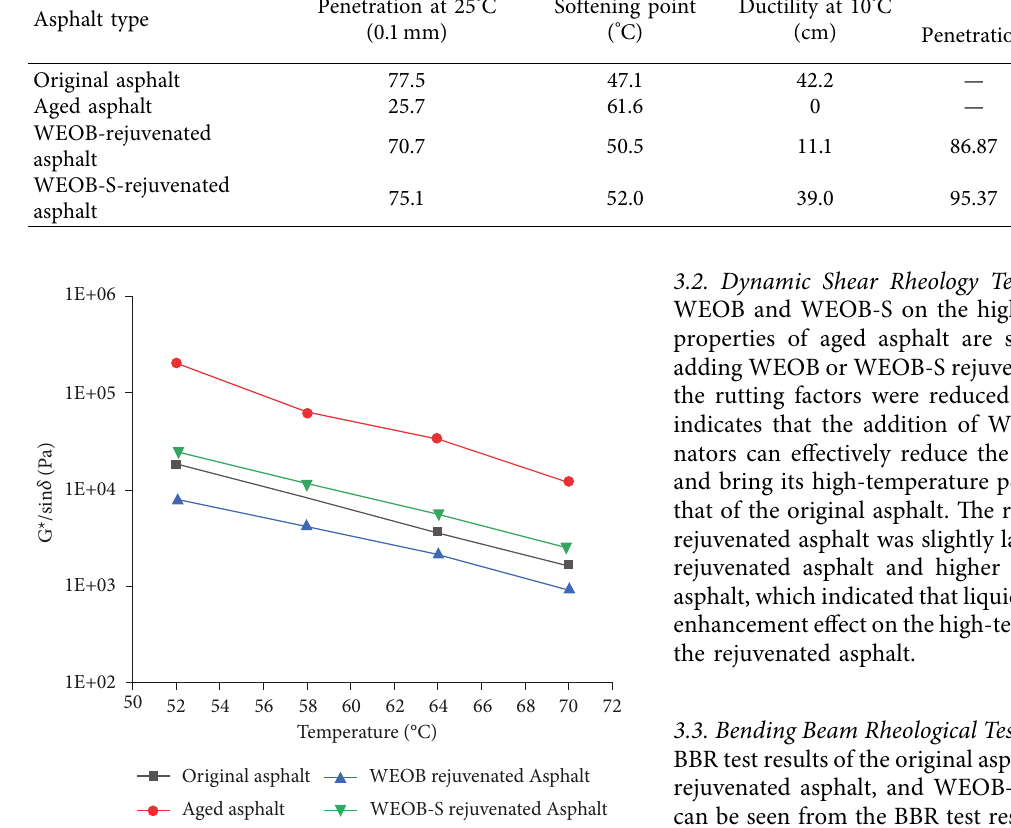
Figure 1: Change of rutting factor before and after asphalt aging and